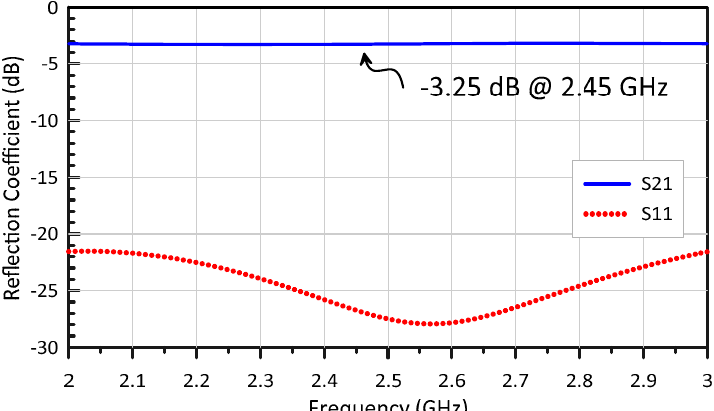
Figure 2. Reflection and transmission coefficient for the CPW to ACPS transition. Due to the symmetry, S31 is not shown.